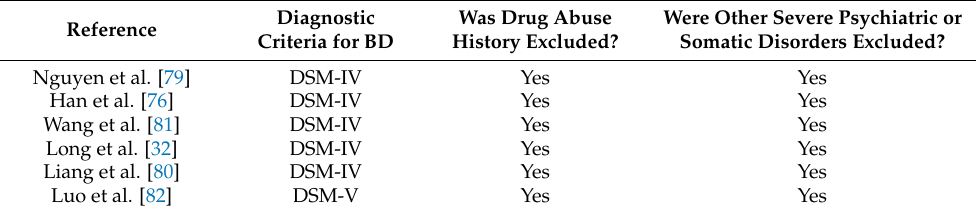
Table A3. Additional information about the studies on bipolar disorder (BD) as mentioned in this manuscript. DSM, Diagnostic and Statistical Manual of Mental